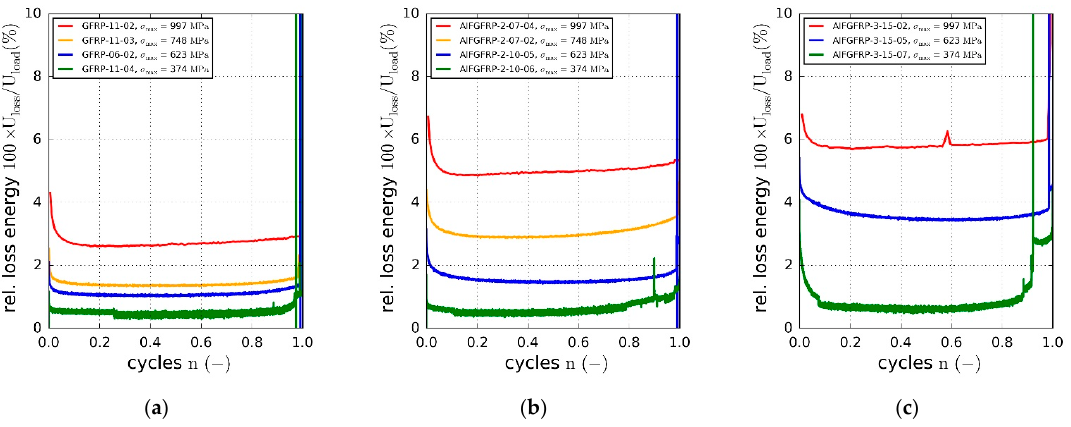
Figure 15. Relative loss energy against the normalized fatigue life: ( a ) reference laminate; ( b ) laminate with work-hardened aluminum fibers; ( c ) laminate with soft-annealed aluminum fibers.